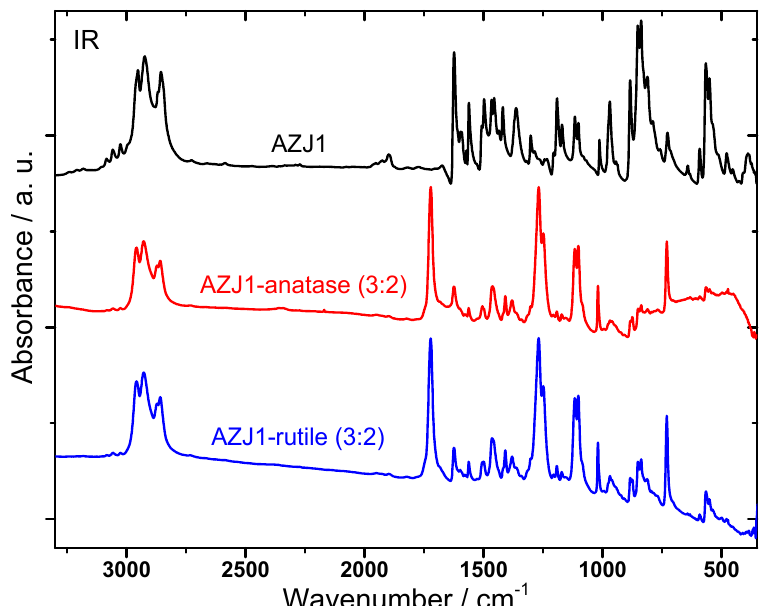
Figure 4. Comparison of room-temperature FT-IR spectra of pure AZJ1, AZJ1–TiO 2 (anatase) and AZJ1–TiO 2 (rutile) mixtures marked with different colors.